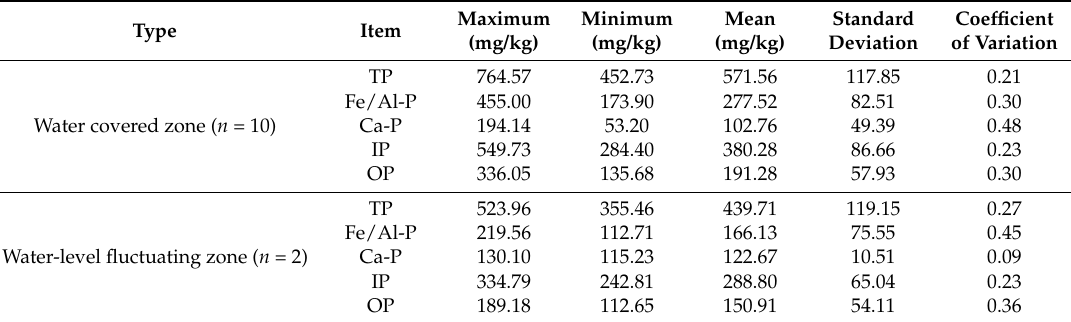
Table 1. Total Phosphorus (TP) and Phosphorus (P) fractions in